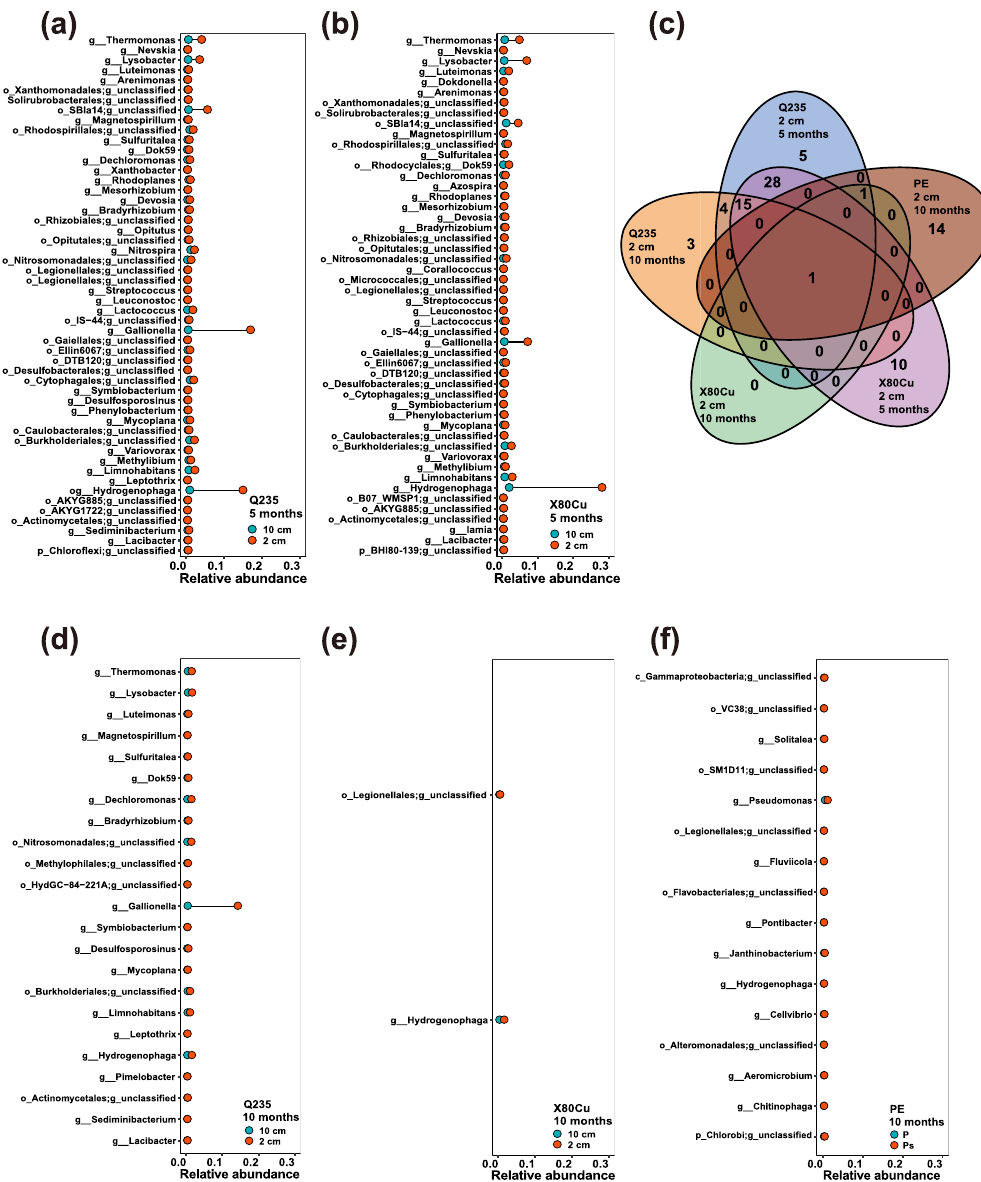
Fig. 5 Taxa with relative abundance signi fi cantly increased in soil samples at 2 cm distance compared to that of 10 cm at the genus level. Distance from Q235 coupons at 5 months ( a ). Distance from Q235 coupons at 10 months ( b ). Distance from Q235 coupons at 5 months ( d ). Distance from Q235 coupons at 10 months ( e ). Distance from polyethylene at 10 months ( f ). Venn diagram of Taxa with increased abundance in different soil samples ( c